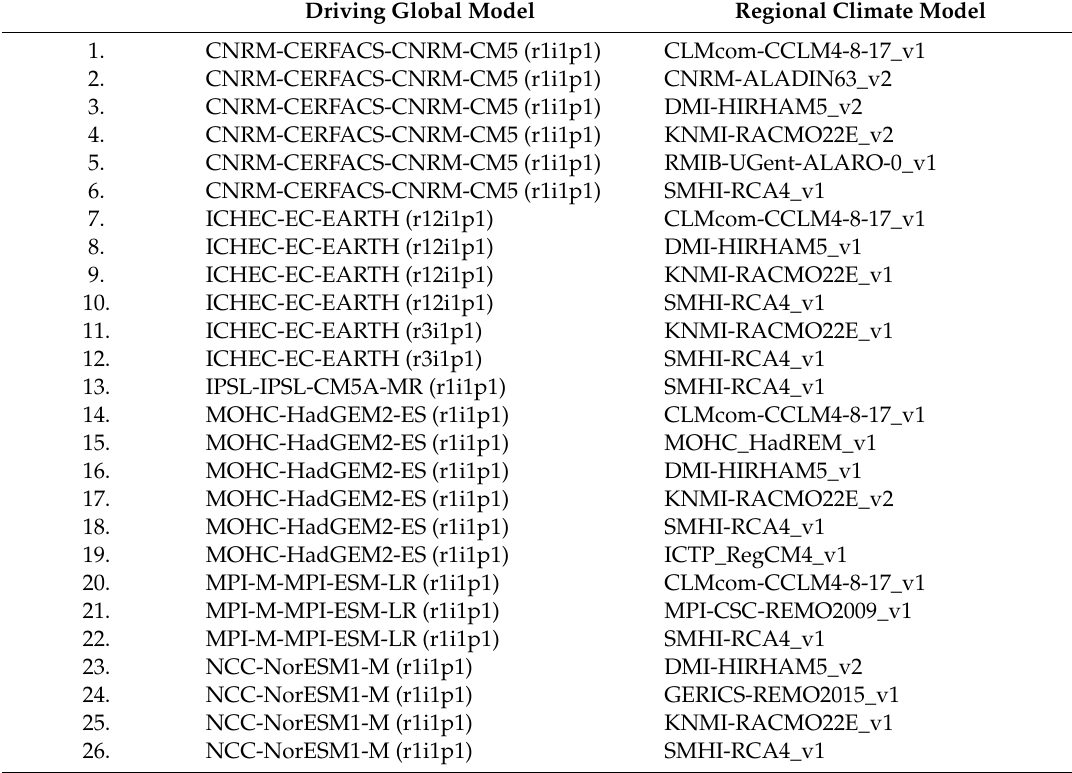
Table 1. List of EURO-CORDEX simulations used for comparison (see ref. [40] for more details and model